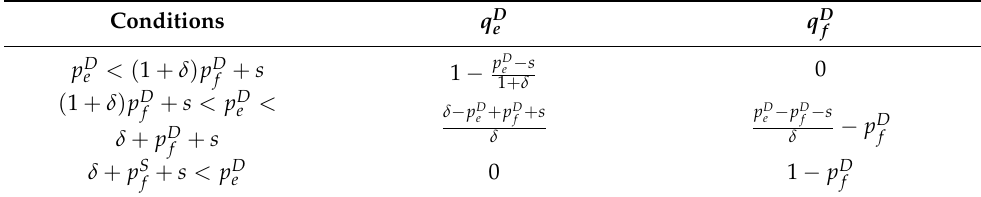
Table 5. Sales quantities of manufacturers under the demand subsidy